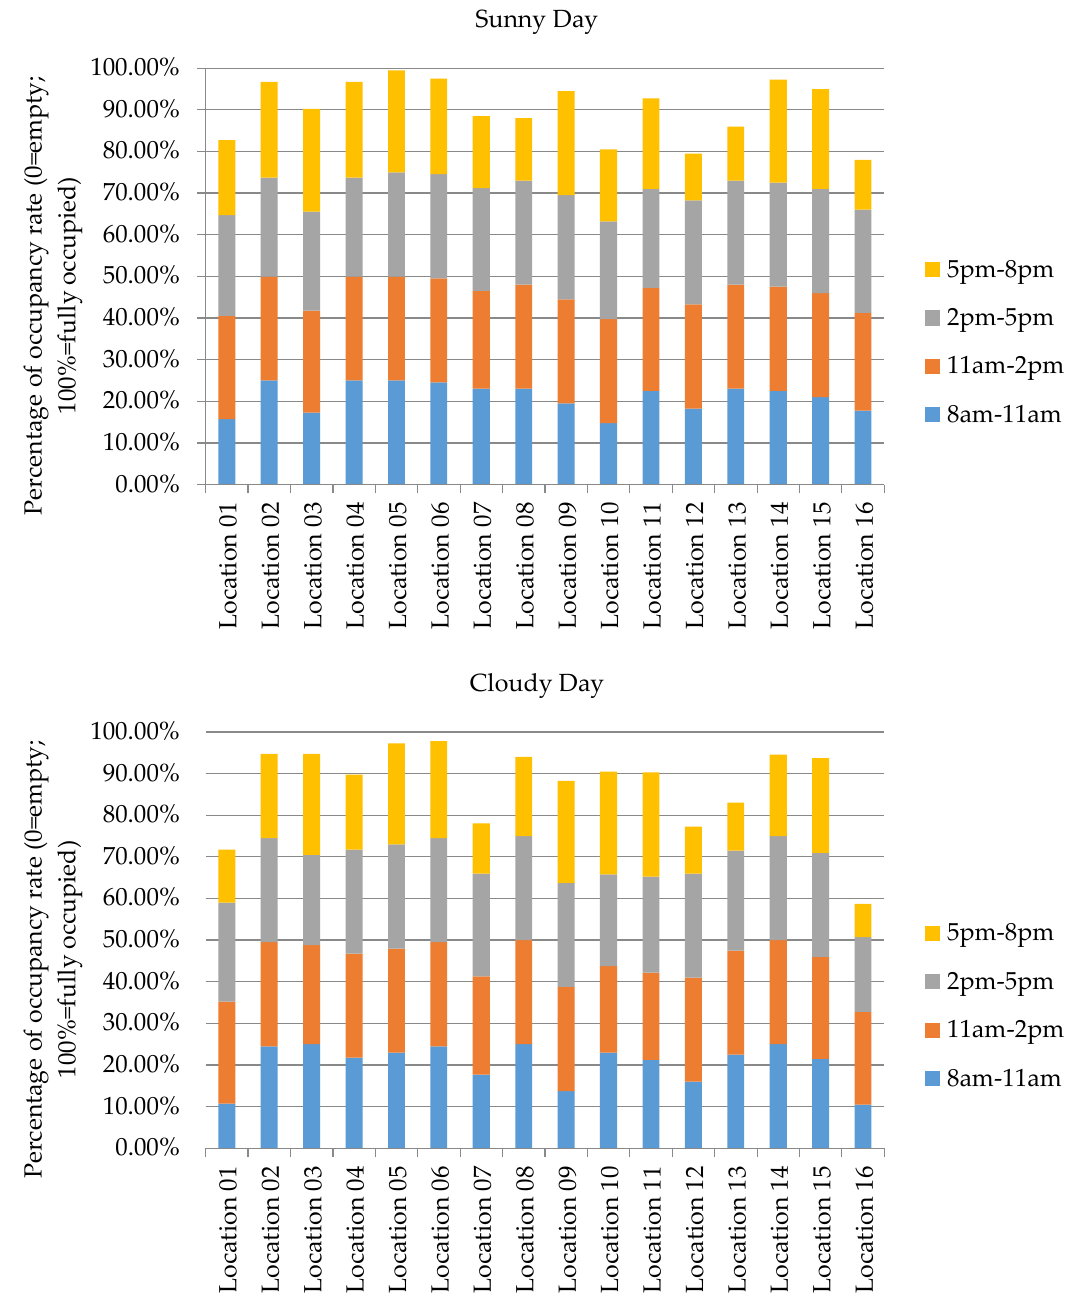
Figure 12. Breakdown of occupancy rates acquired by PIR sensors.